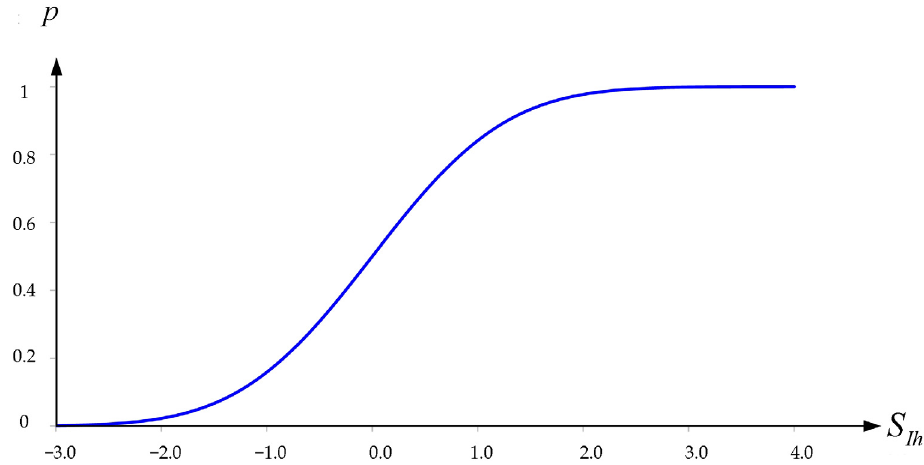
Figure 1. The relationship between service efficiency index and service accomplishment rate .